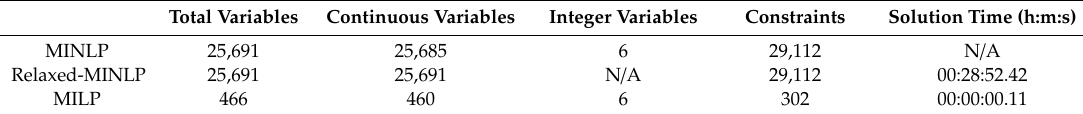
Table 7. Computational and model statistics for the Oklahoma case.